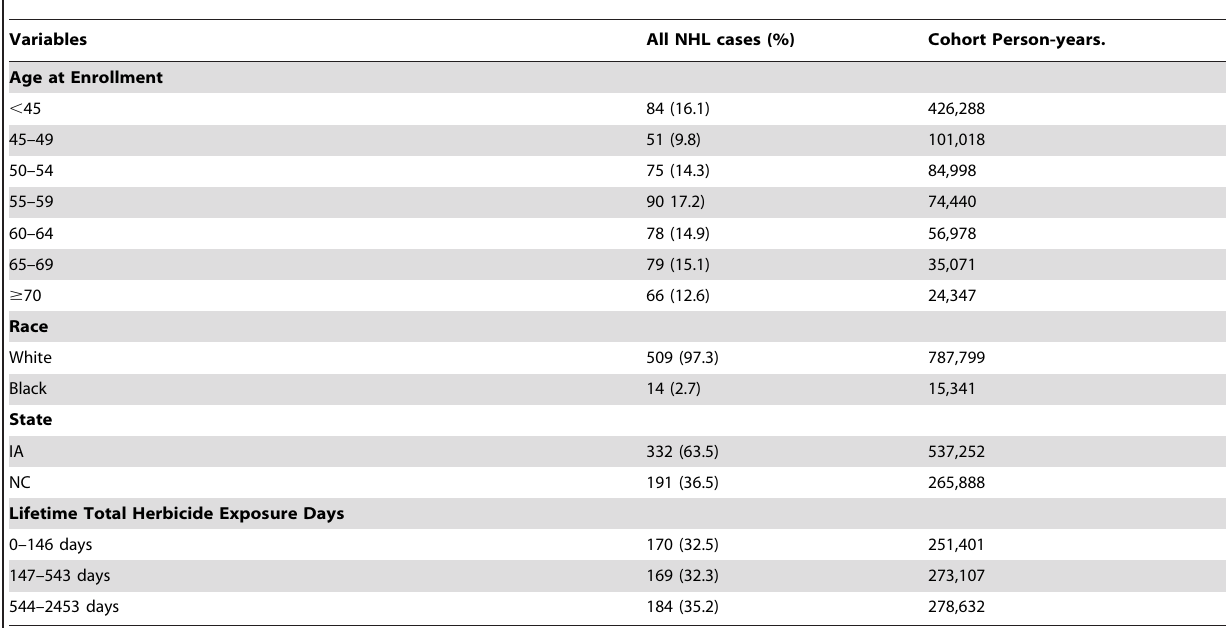
Table 1. Baseline characteristics of AHS study participants in the NHL incidence analysis 1,2 .